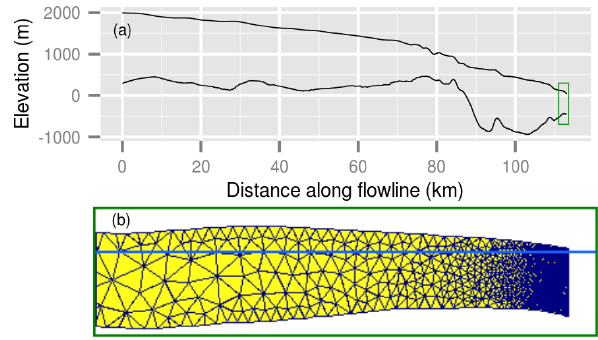
Figure 2. (a) Surface and basal geometry of central flow line used in this study. (b) Model mesh of region outlined by green box in (a) . The blue line represents sea